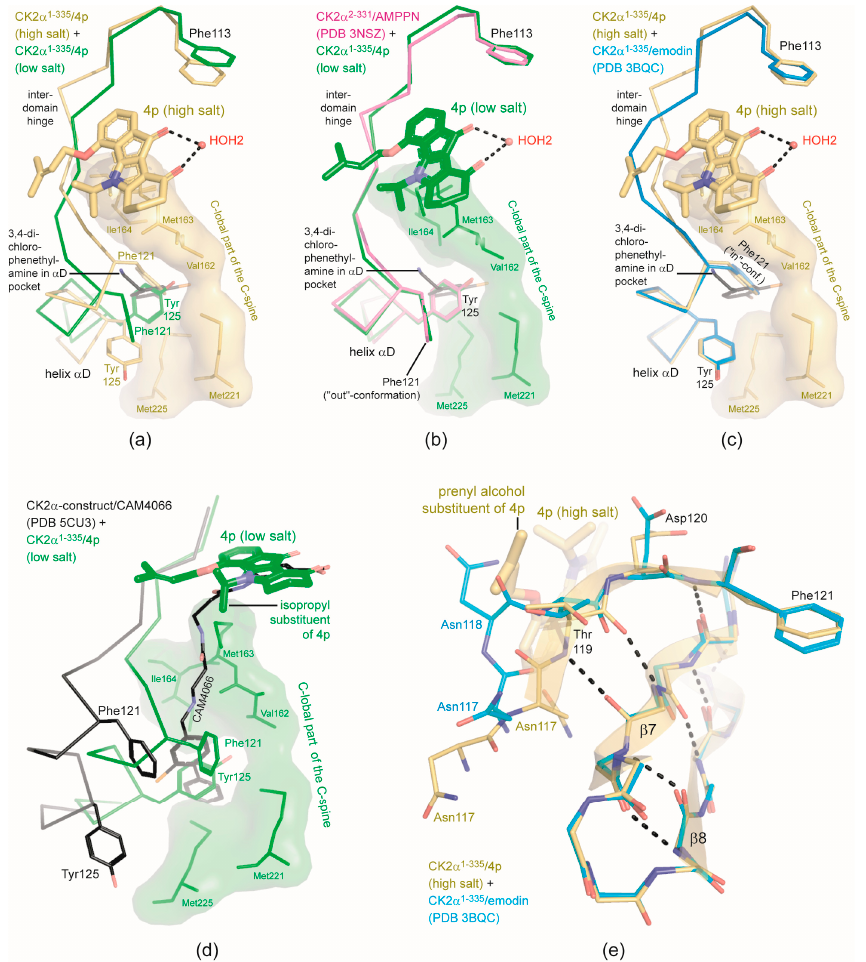
Figure 5. Hinge/helix α D region conformations of CK2 α compatible with 4p binding. ( a – c ) Pairwise comparisons of the hinge/helix α D of the high-salt and the low-salt CK2 α 1 − 335 / 4p structure ( a ), of the low-salt CK2 α 1 − 335 / 4p structure (green) and the high-resolution human CK2 α structure 3NSZ (magenta) serving as a reference for the open (Phe121-out) conformation ( b ) and of the low-salt CK2 α 1 − 335 / 4p structure (yellow) and 3BQC (blue), a typical closed-conformation human CK2 α structure (Phe121-in) ( c ). The C-terminal domain part of the catalytic spine is drawn with a surface representation from the high-salt ( a , c ) or from the low-salt CK2 α 1 − 335 / 4p structure ( b ) in order to illustrate the hydrophobic environment of the α D pocket which is indicated in all three pictures by the ligand 3,4-dichlorophenethylamine (black C-atoms) from PDB 5CLP [19]. ( d ) Overlay of the low-salt CK2 α 1 − 335 / 4p structure (green) with PDB 5CU3 [19] (black C-atoms), a complex structure of a human CK2 α construct (with an N-terminal extension, a C-terminal deletion and the point mutation Arg21Ser) with the bivalent inhibitor CAM4066 addressing the ATP-site and the α D pocket in parallel. ( e ) Overlay of the high-salt CK2 α 1 − 335 / 4p structure (yellow C-atoms) with PDB 3BQC (blue C-atoms) to illustrate an extension of the antiparallel β -sheet β 7/ β 8 (Figure 3a) by an additional β -strand established in the middle part of the hinge/helix α D region and being one residue longer in the high-salt CK2 α 1 − 335 / 4p complex than in the CK2 α 1 − 335 /emodin complex. β -sheet-typical H-bonds in the CK2 α 1 − 335 / 4p complex are depicted as dotted lines. For reasons of clarity no side chains are drawn for the residues of the strands β 7 and β 8.